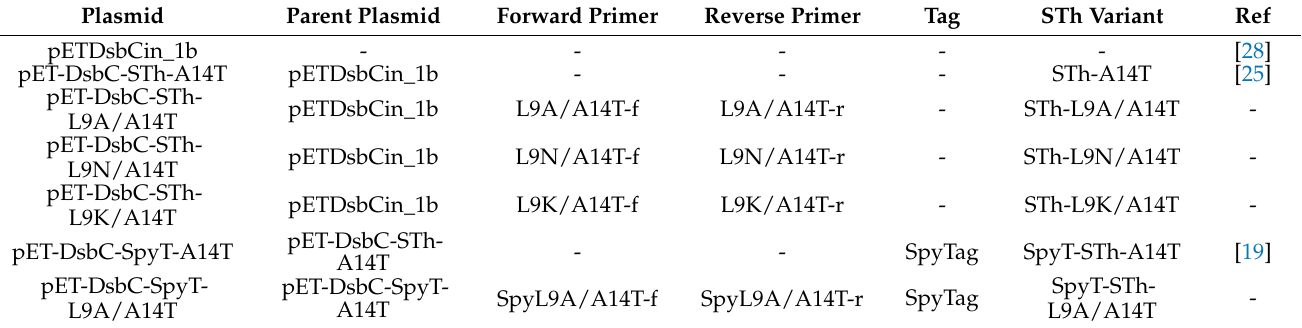
Table 2. Plasmids used to construct and express untagged and tagged STh mutant